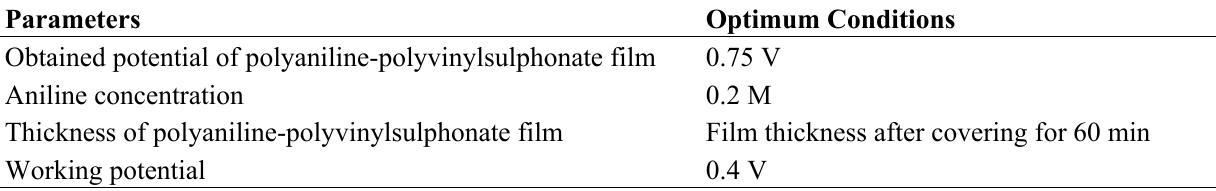
Table 1. The optimum conditions for preparation of Pt/Pani-Pvs electrode.